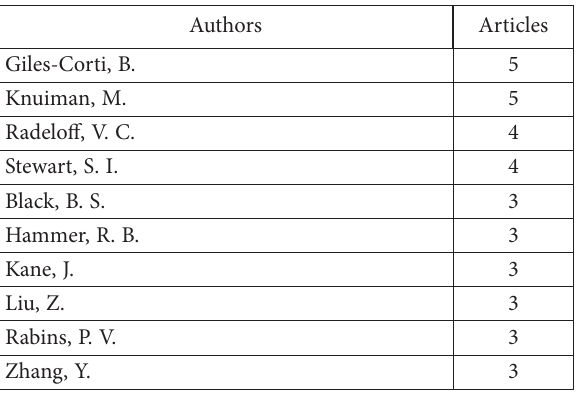
Table 5. Most prominent authors with maximum